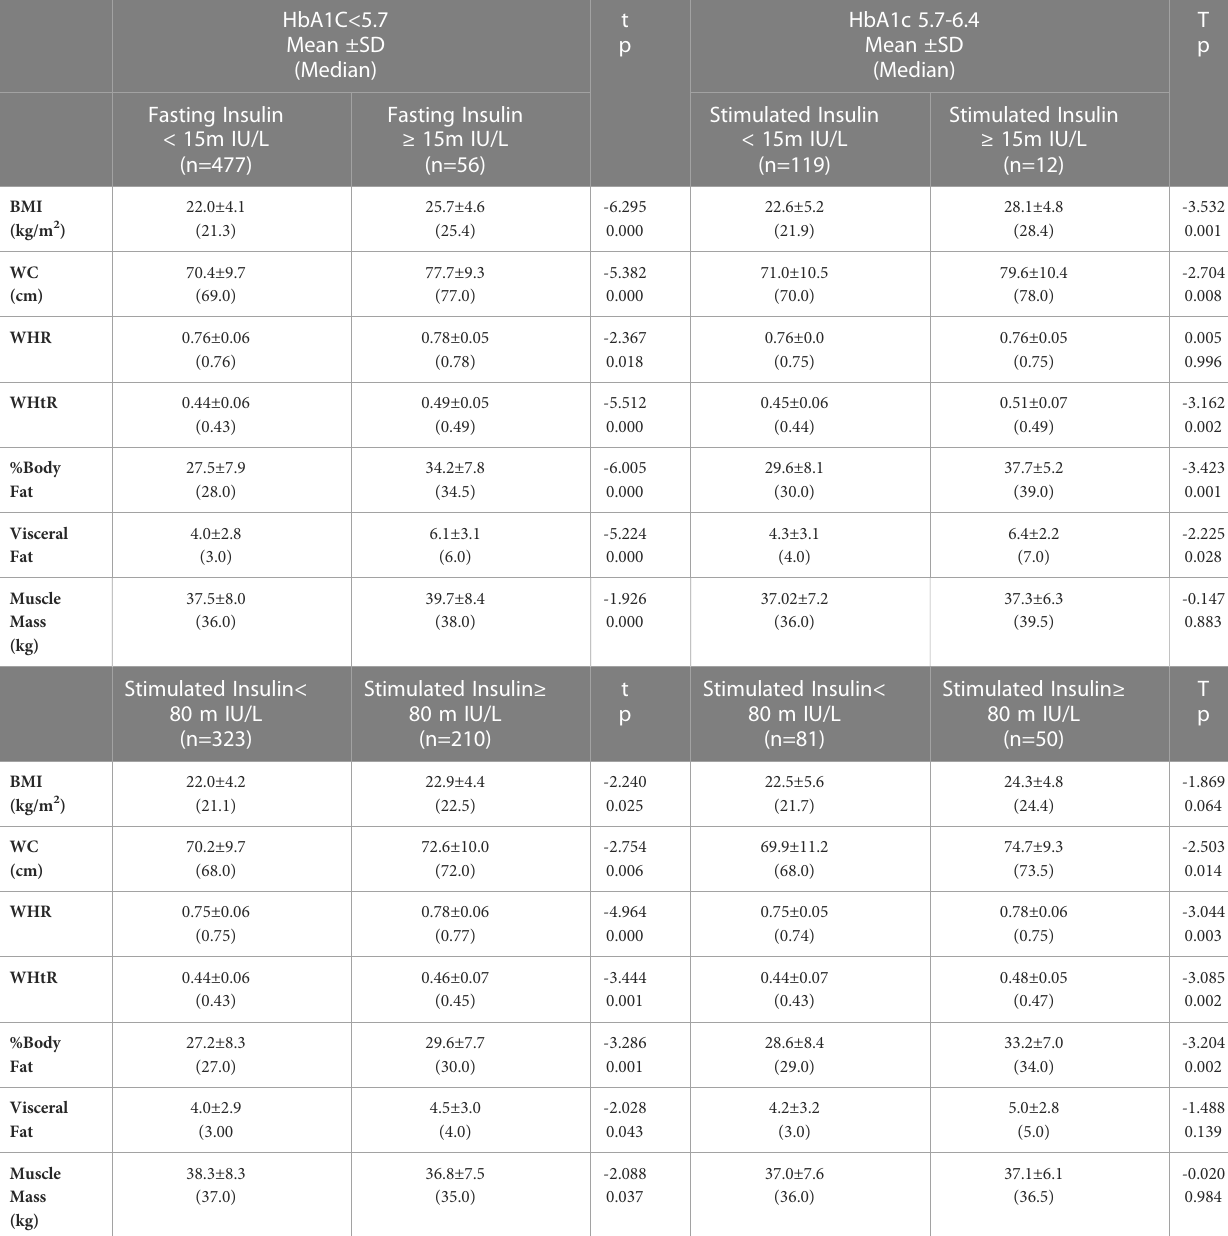
TABLE 4 Comparison of mean anthropometric indices between participants having HbA1c<5.7 and those with HbA1c between 5.7 and 6.4 with normal and elevated fasting and stimulated insulin levels.